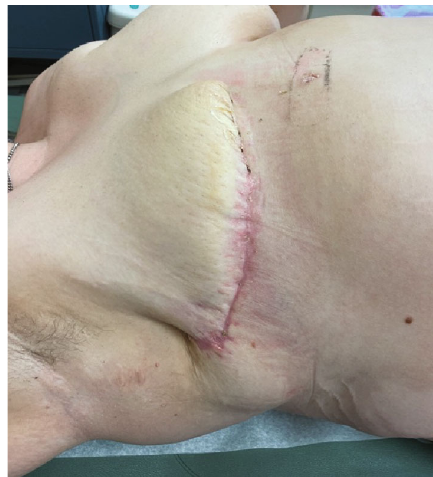
Figure 3: Well-healed mastectomy incision seen at 1-month postoperation; drains were